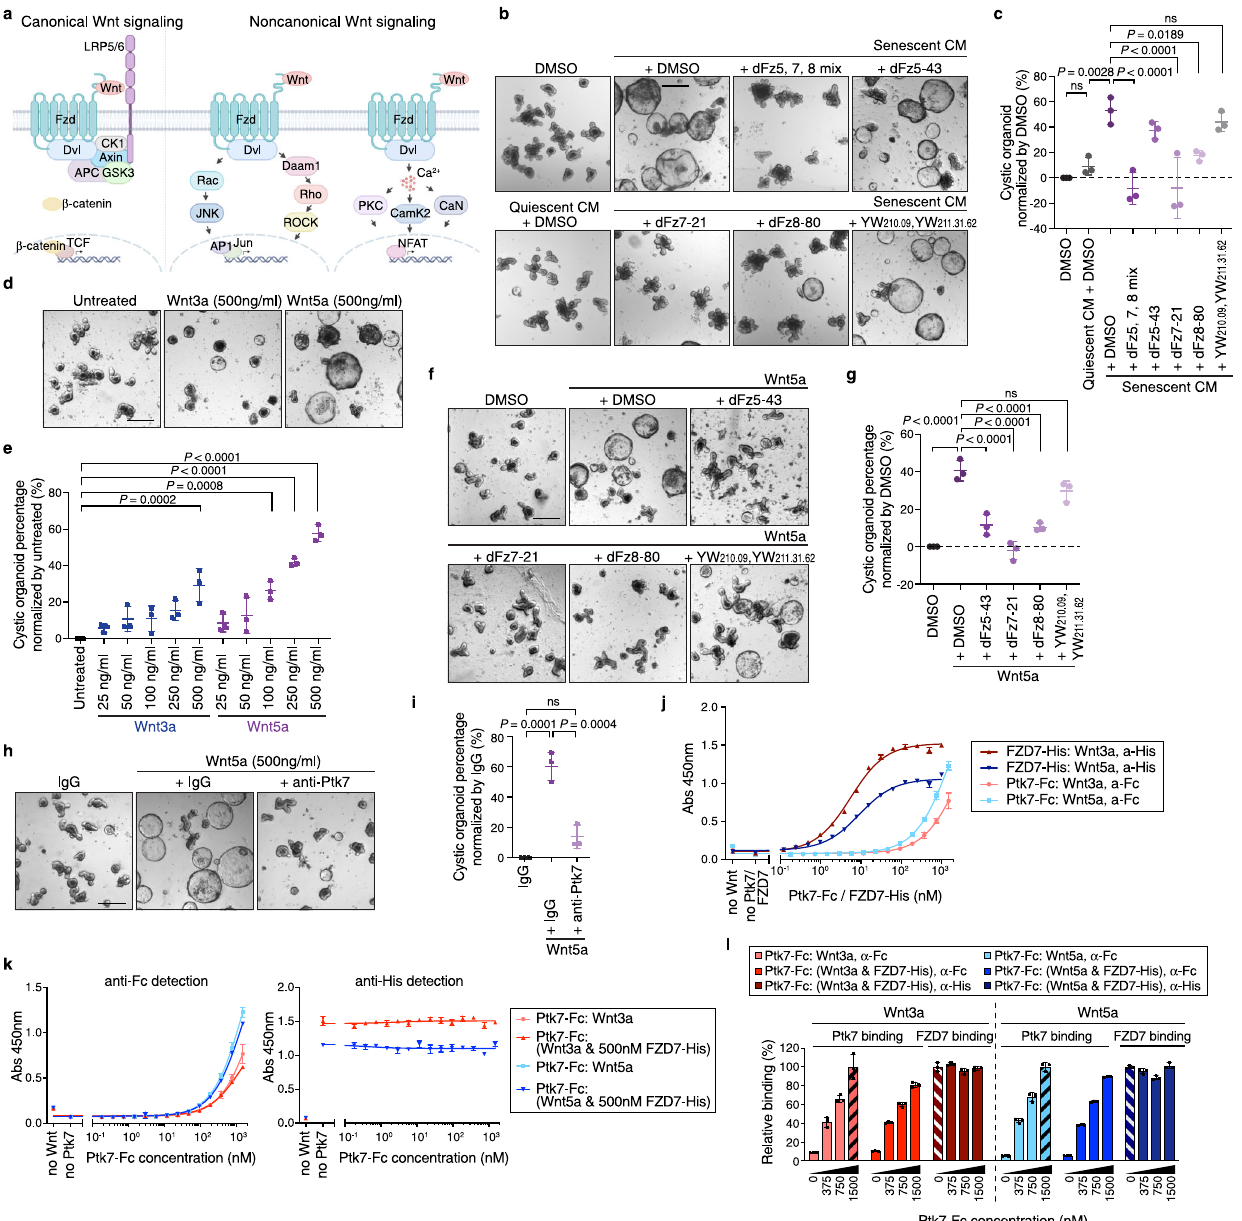
Fig. 4 | Ptk7 acts through noncanonical Wnt signaling. a Schematic repre- sentation of canonical and noncanonical Wnt signaling pathways. While canonical and noncanonical Wnt signaling pathways share components suchasFZDand Dvl, other components such as LRP5/6 and β -Catenin are speci fi c for canonical Wnt signaling. The fi gure was created with BioRender.com. b Representative images of organoids cultured in corresponding conditioned media with DMSO or inhibitors. Scale bar, 200 μ m. c Quanti fi cation of data from ( b ). The percentage of cystic organoids in organoids cultured in conditioned media is shown. d Representative images of organoids treated with DMSO (carrier), Wnt3a or Wnt5a. Scale bar, 200 μ m. e Quanti fi cation of data from ( d ). The percentage of cystic organoids in organoids cultured in conditioned media is shown. f Representative images of organoids cultured in Wnt5a with DMSO or inhibitors. Scale bar, 200 μ m. g Quanti fi cation of data from (f). mean ± s.d. percentage of cystic organoids in organoids cultured in conditioned media. h Representative images of organoids